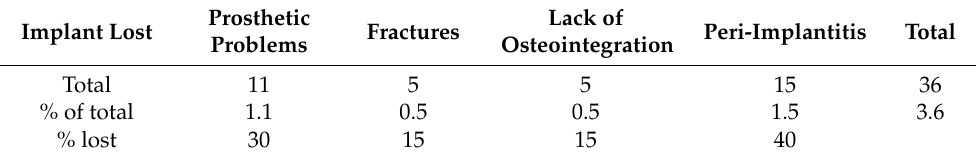
Table 3. Ossean ® implants